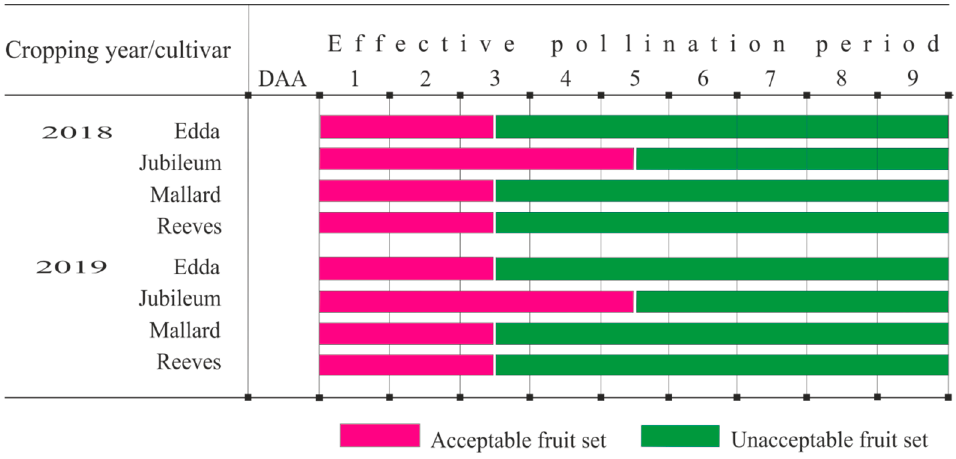
Figure 5. The duration of the EPP in four studied plum cultivars during